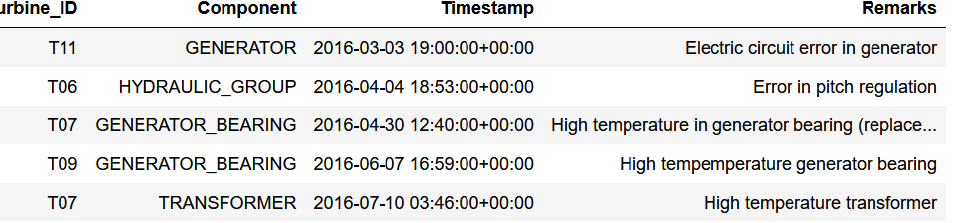
Figure 4. Failure